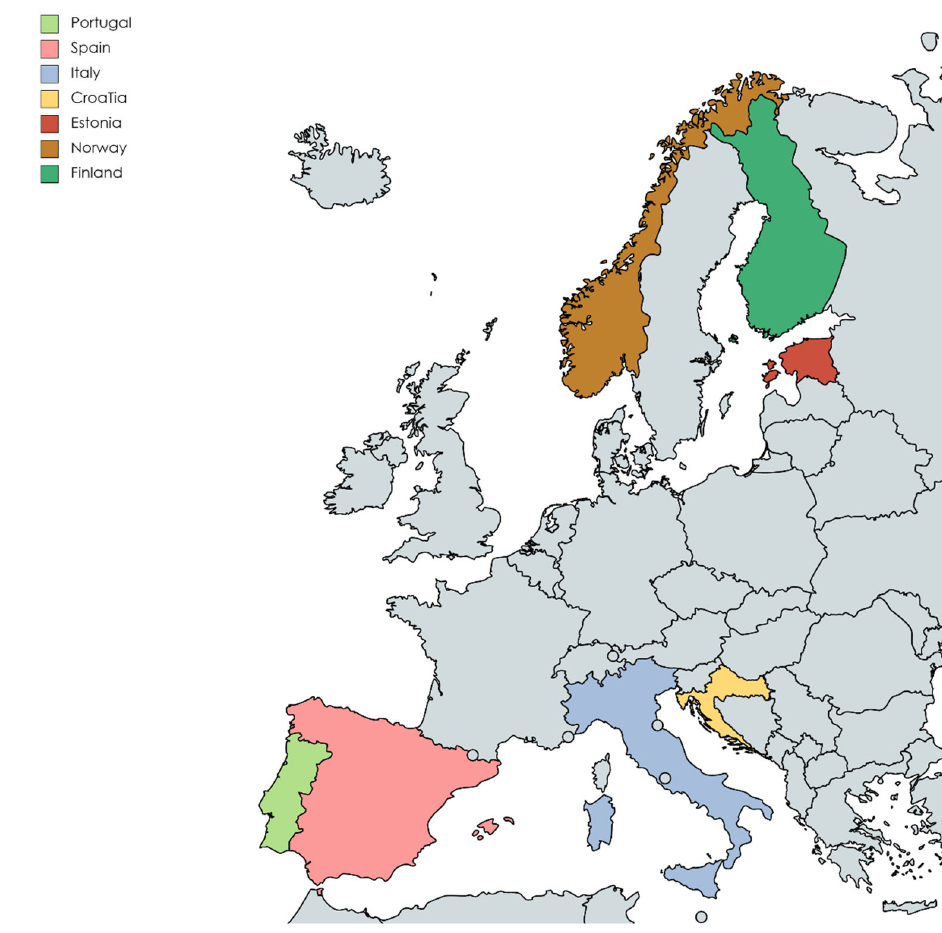
Figure 1. Geographical location of the countries included in the study.